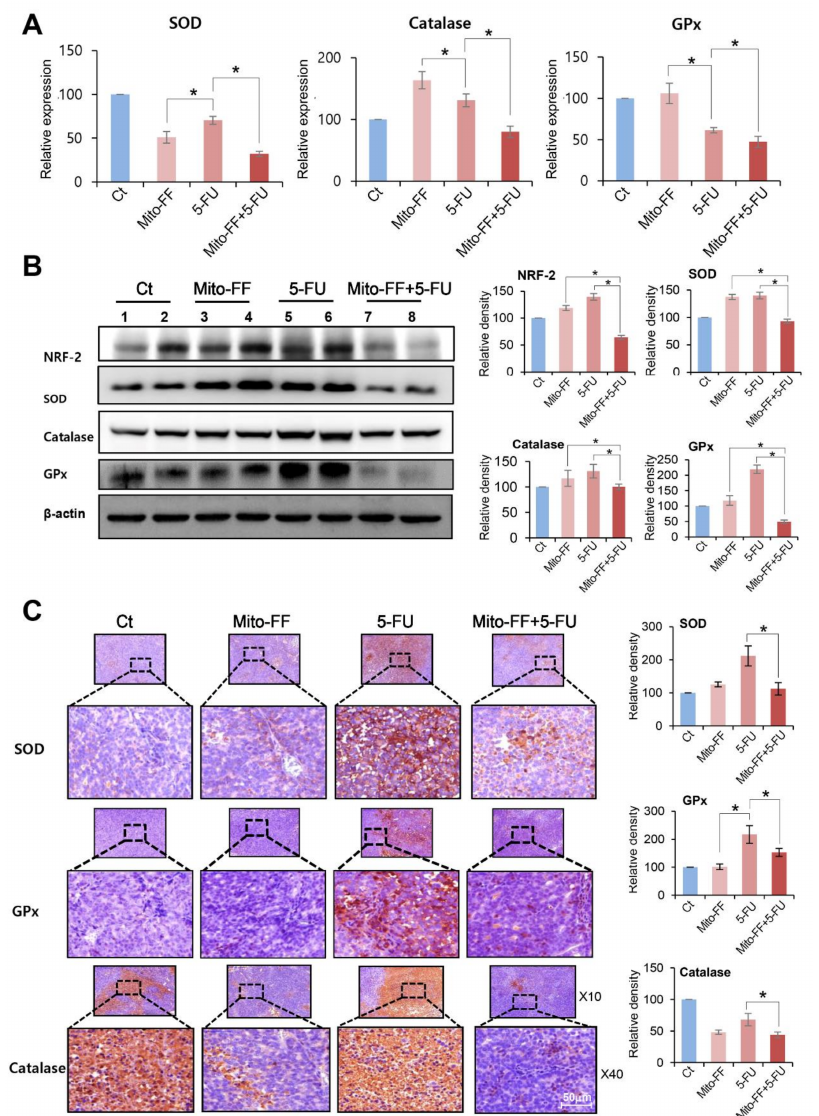
Figure 5. Determination of antioxidant activities of individual treatments in the xenografted AGS cells. ( A ) Real-time PCR using specimens obtained from xenografted AGS cells following individual treatments. Combination therapy most significantly reduced the RNA expression of antioxidant enzymes, including catalase, SOD,andGPxcomparedtomonotherapy. ( B )Westernblotanalysesusingspecimensobtainedfrom xenografted AGS cells following individual treatments. Combination therapy most significantly reduced the expressionofNRF-2andvariousantioxidantenzymescomparedtomonotherapy. ( C )Immunohistochemical stains demonstrating that combination therapy most significantly reduced the expression of antioxidant enzymes, including SOD, catalase, and GPx compared to the monotherapy. Values are presented as mean ± standard deviation of three independent experiments. * P <